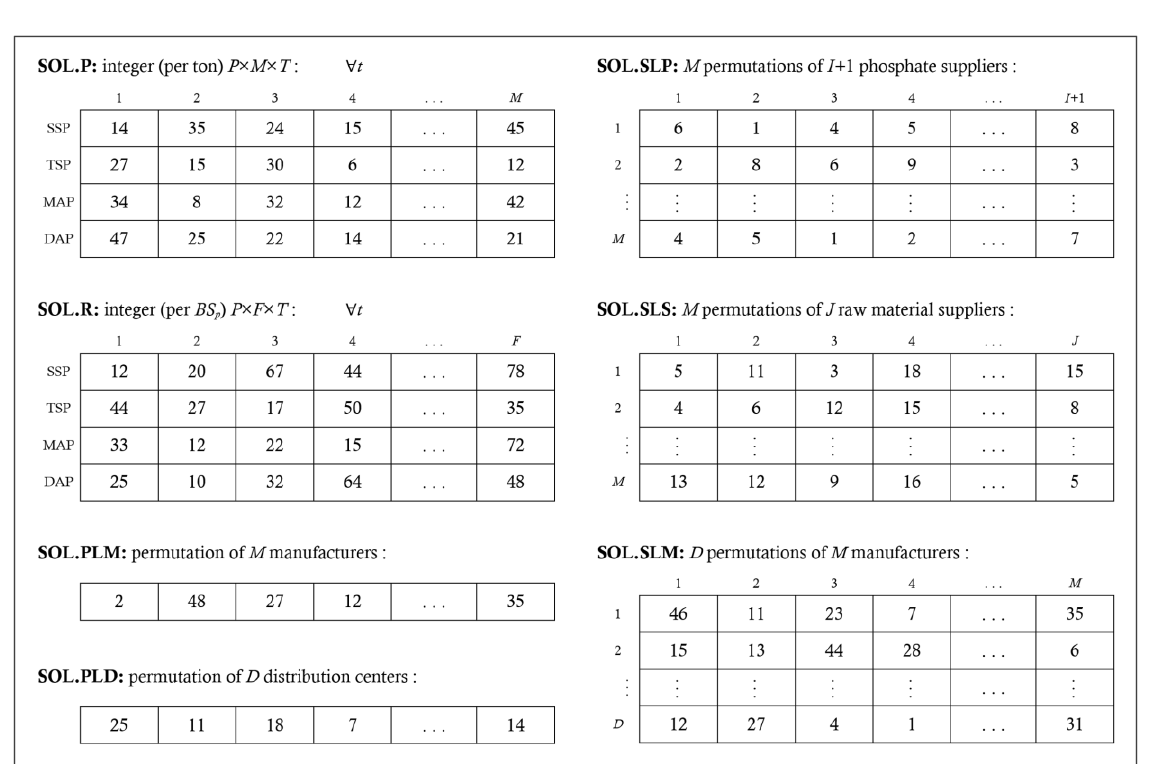
Figure 3. Encoding of the direct DVs into a feasible solution.